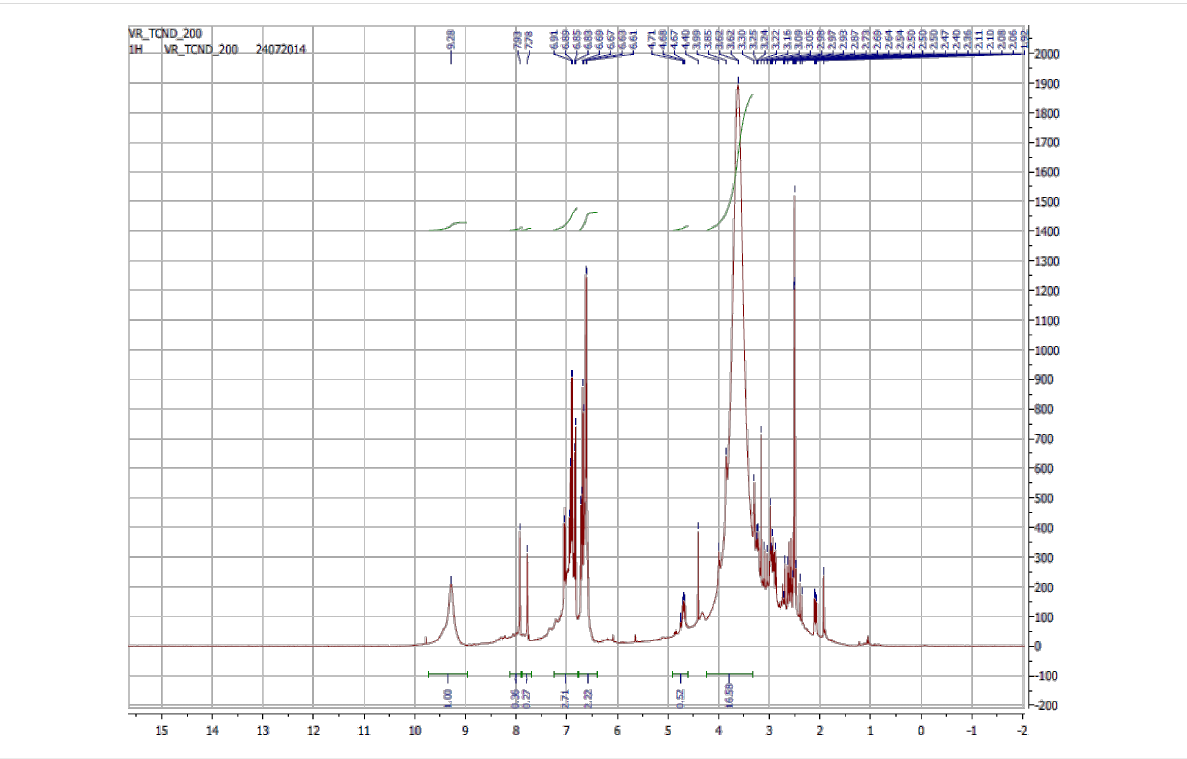
Figure 4: Recorded 1 H NMR spectrum of TCND-1 in DMSO- d 6 .